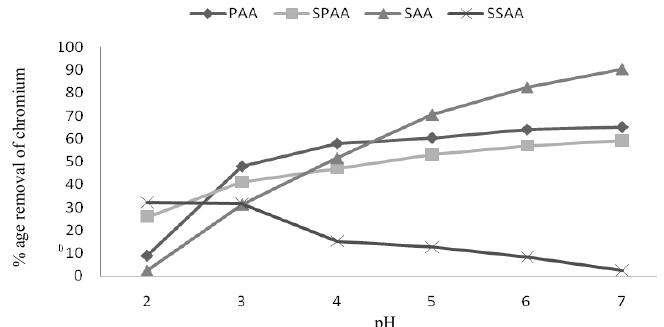
Figure 5. The effect of pH on adsorption of Cr(III)